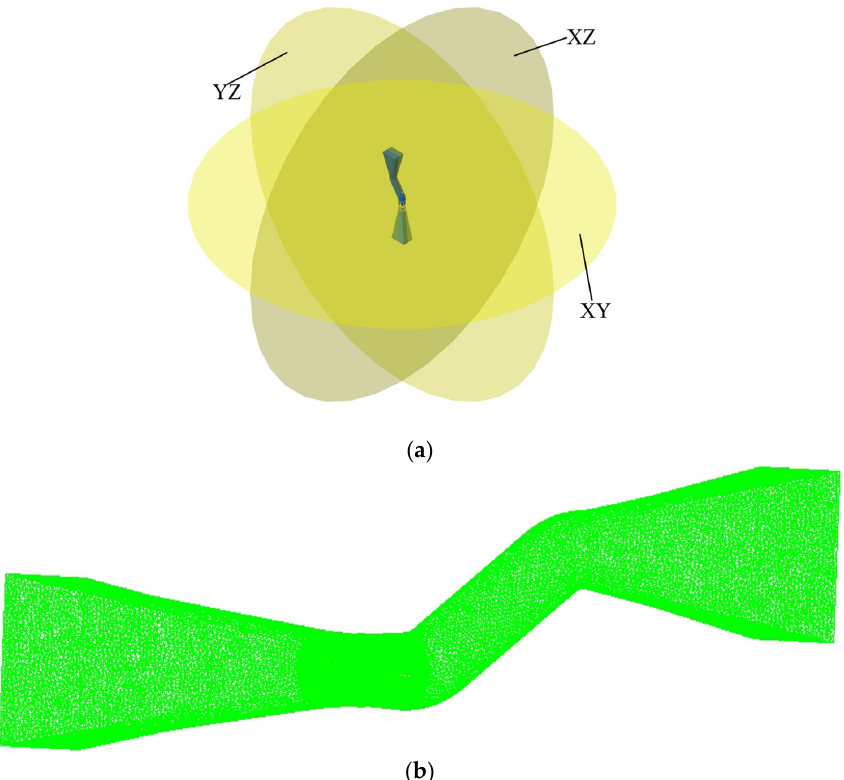
Figure 5. Sound field settings. ( a ) Sound field monitoring surface. ( b ) Acoustic computation grid.